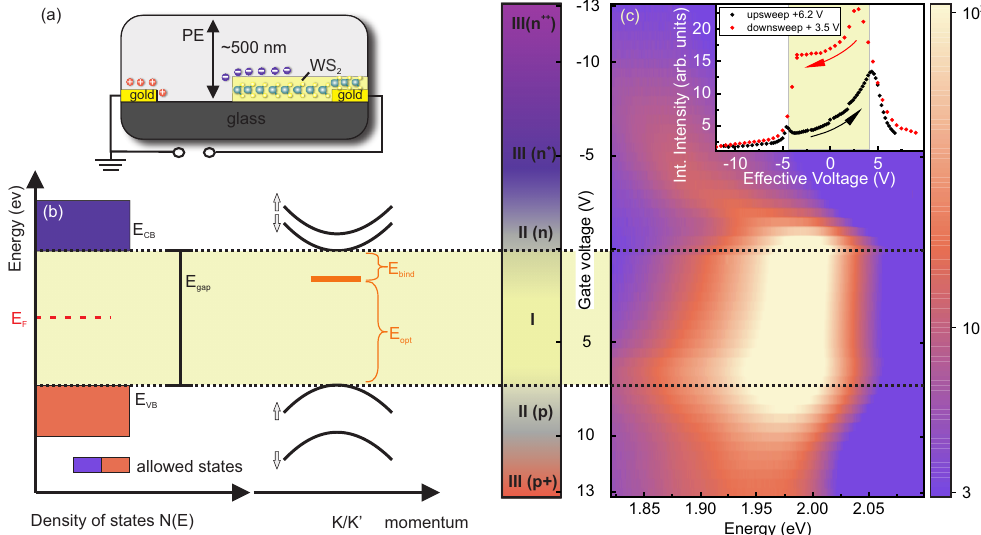
Figure 1. ( a ) Sketch of the 1 L WS 2 field-effect structure using a solid electrolyte gate electrode. ( b ) Schematic density of states N(E) and the single-particle band structure close to the fundamental band-gap for a 2D semiconductor. Since the electrochemical potential µ of the gate electrode is aligned with the Fermi level E F of the WS 2 semiconductor, E F can be tuned by an applied gate voltage. ( c ) PL spectra in a false-color representation for varying gate voltages V g 13 V to − 13 V. The emission intensity is color-coded. When the chemical potential and, hence, E F is aligned with the CB and VB edges, an enhanced emission intensity occurs. Intensity and lineshape is interpreted as interplay of screening and doping dependent behavior of the rich exciton manifolds in WS 2 MLs. Inset: Integrated intensities for gate up and down sweeps (hysteresis-corrected). [ T = 300 K, λ Laser = 532 nm; P = 50 µ